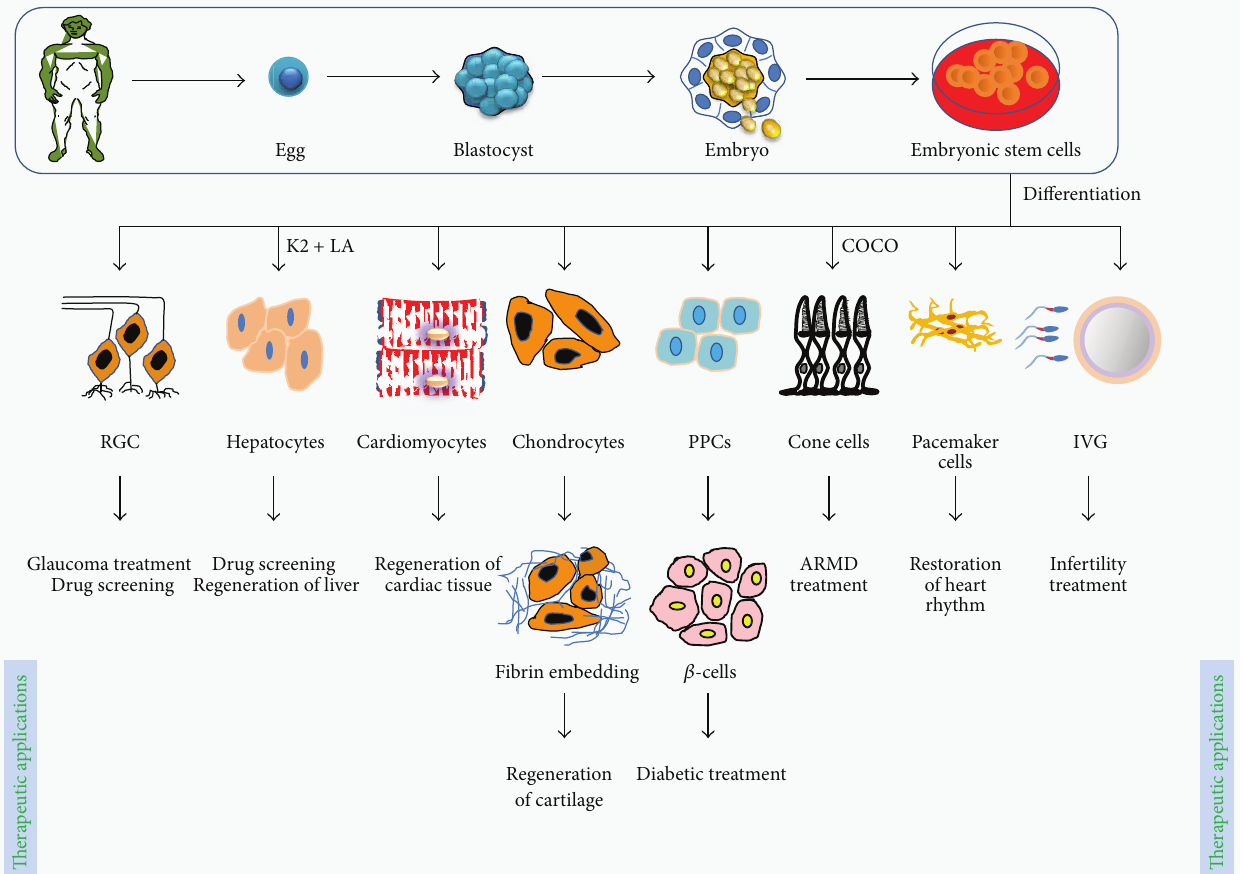
and transdifferentiation processes [14] has been considered as critical regulatory switch for lineage commitment of